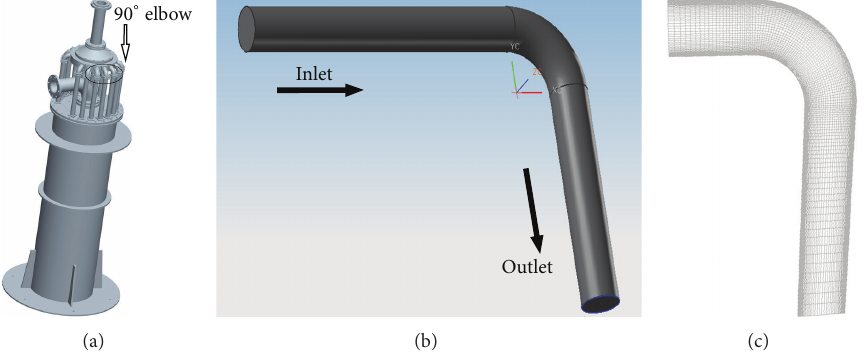
Figure 3: Three-dimensional views of 90 ∘ elbow of steam generator and established CFD model. (a) Structural 90 ∘ elbow of steam generator; (b) CFD model; (c) the view of mesh distribution of the axial cross section.